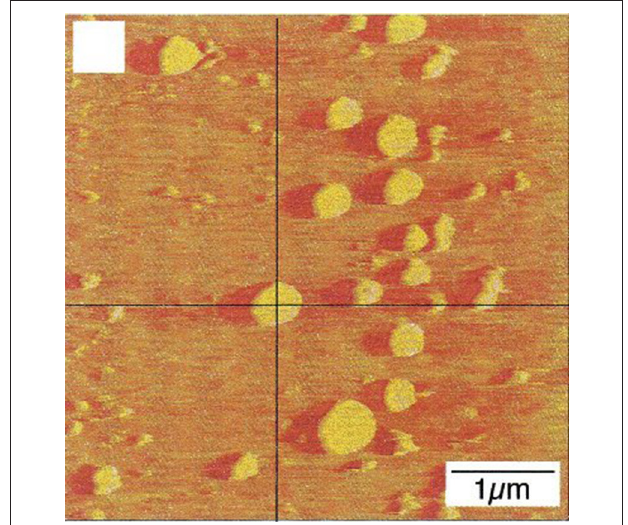
FIGURE 1 | Evolution of nanobubbles on a hydrophobic surface. Nanobubbles which evolved from dissolved gas on a hydrophobic surface observed using atomic force microscopy (taken from Tyrrell and Attard, 2001 with permission).